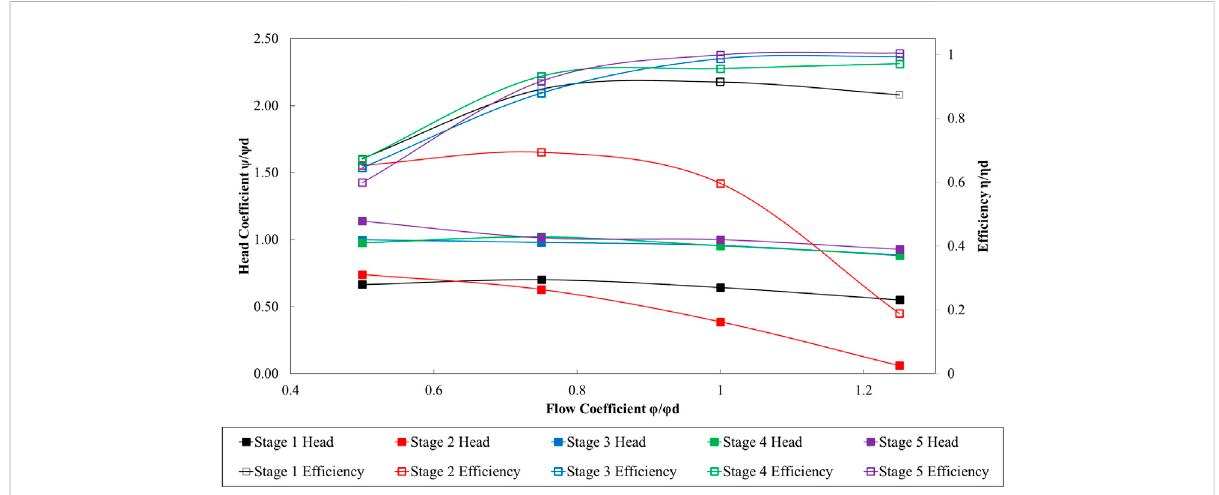
FIGURE 6 Stage-wise performance of the reference pump.